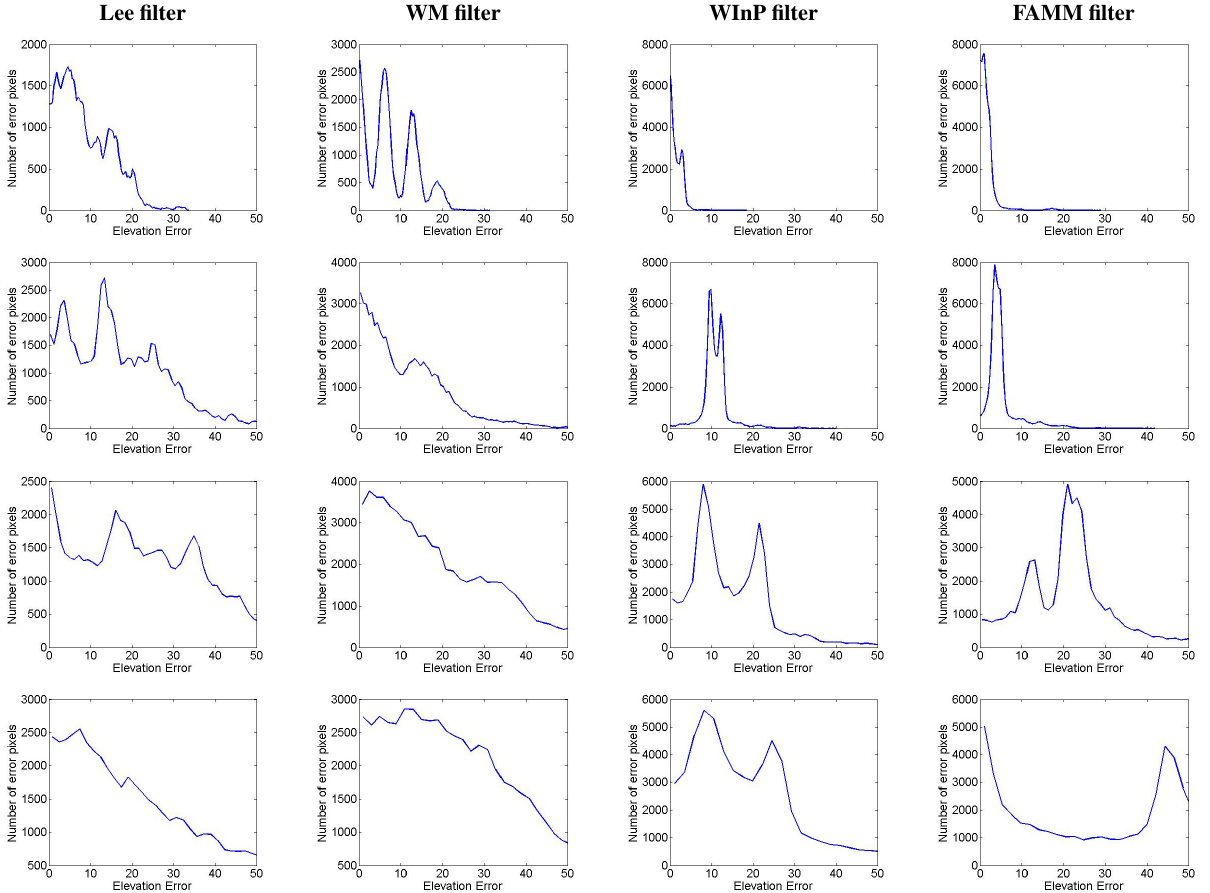
Figure 5: The distribution histogram of the elevation error between the original unwrapped phase image and the unwrapped filtered interferogramof Fig. 3. The first row: the interferogram of Fig. 3 (a), the second row: the interferogram of Fig. 3 (b), the third row: the interferogram of Fig. 3 (c) and the fourth row: the interferogram of Fig. 3